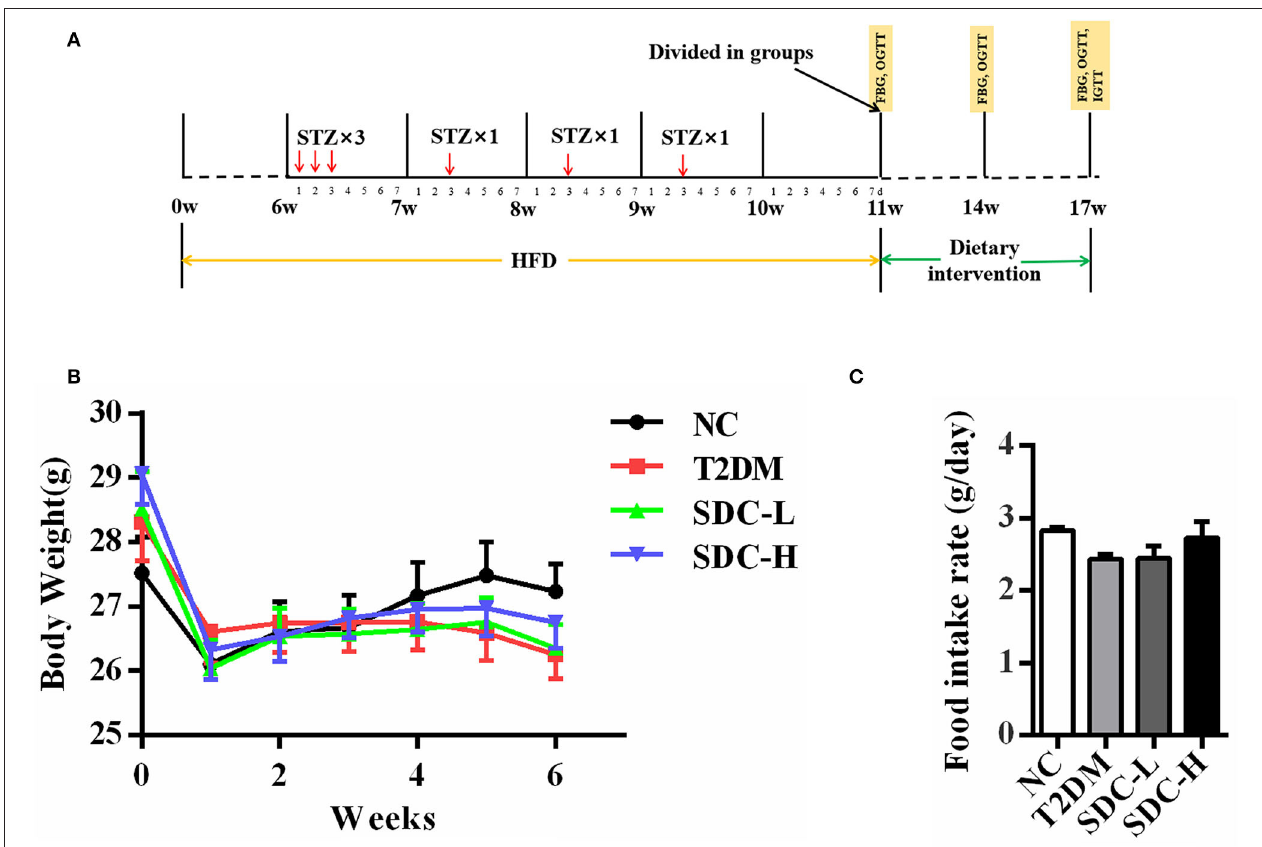
FIGURE 1 | (A) Schematic representation of experimental procedure; (B) Body weight of the mice during the intervention period, n = 11; (C) Food intake of the mice during the intervention period, n =